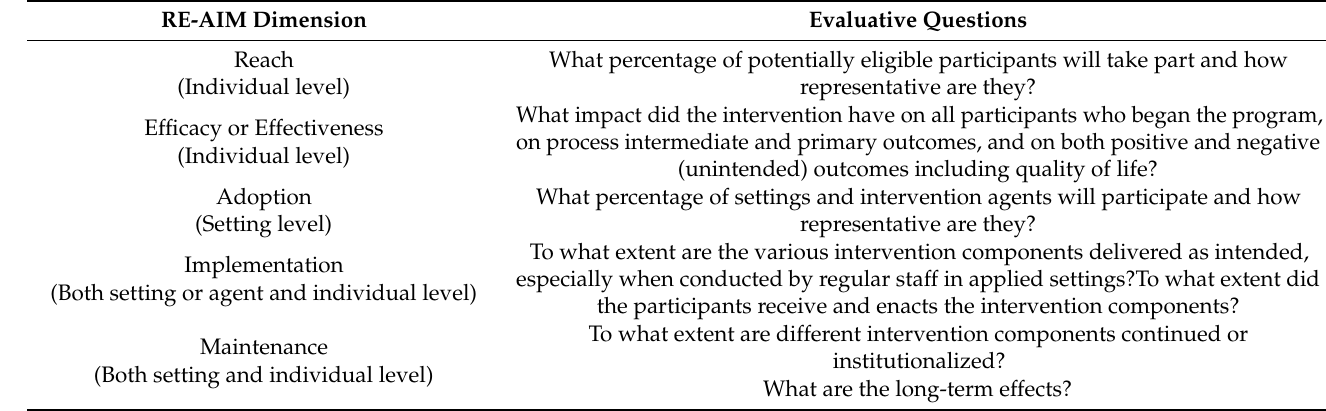
Table 1. Reach, Effectiveness, Adoption, Implementation, and Maintenance (RE-AIM) Dimensions and their evaluative questions. Based on Glasgow [32] and Estabrooks & Gyurcsik